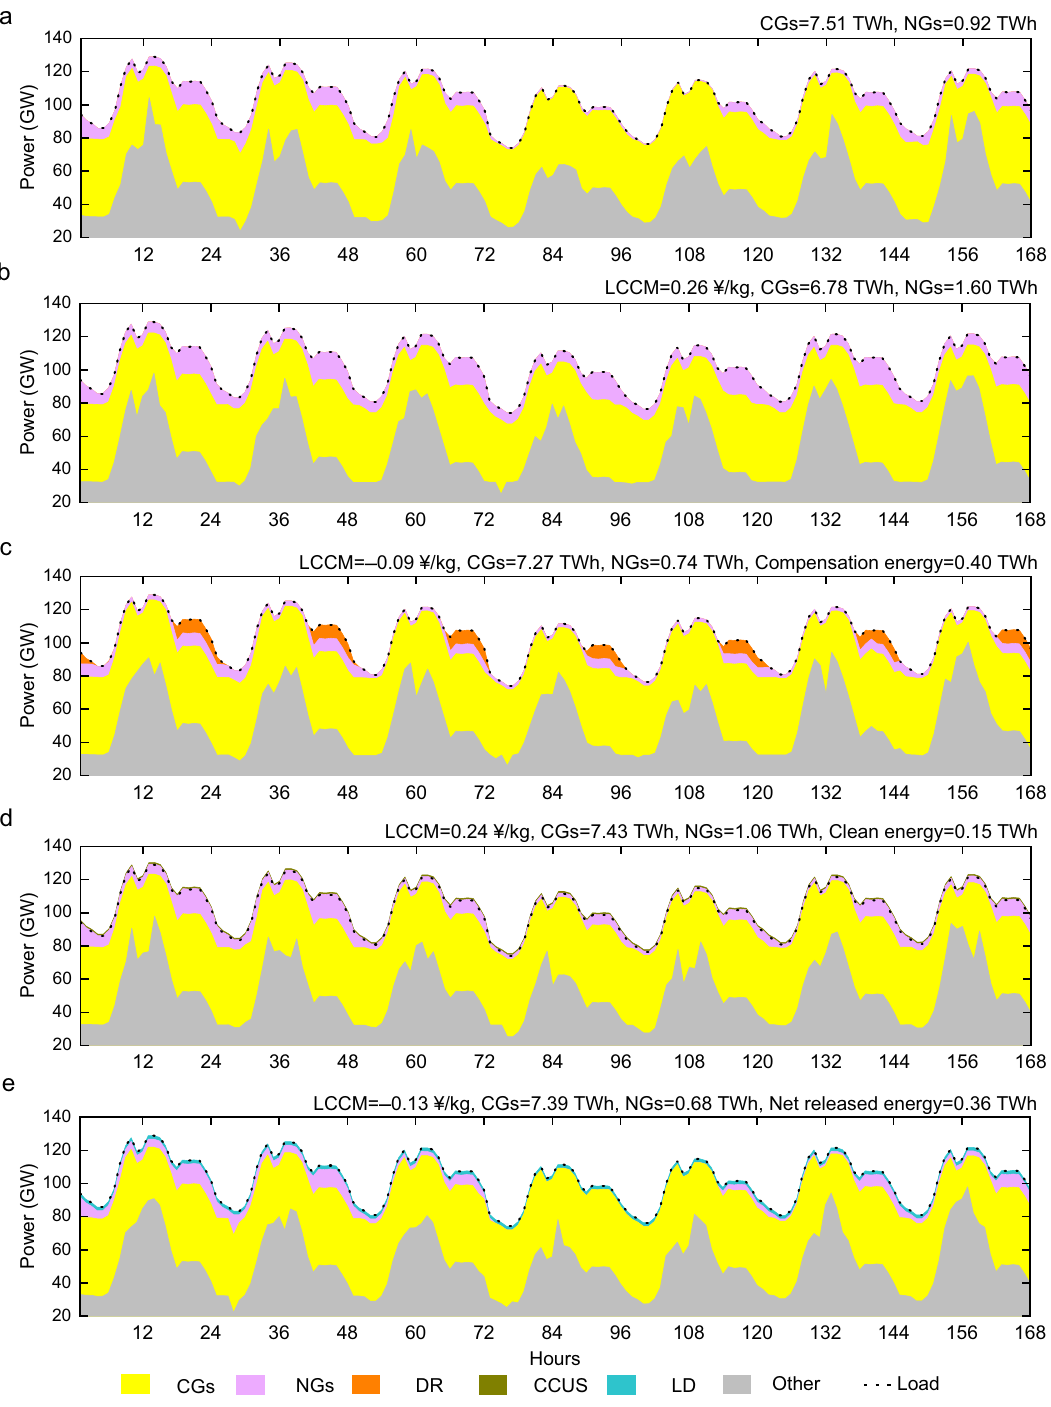
Fig. 6 Hourly power balance. a Power balance without any measures. b Power balance considering coal power to natural gas power (C2N). c Power balance considering C2N + demand response (DR). d Power balance considering C2N + carbon capture, utilization and storage (CCUS). e Power balance considering C2N + long-duration (LD). Note that “ LCCM ” , “ CGs ” , and “ NGs ” are short for levelized cost of CO 2 mitigation, coal generators, and natural gas